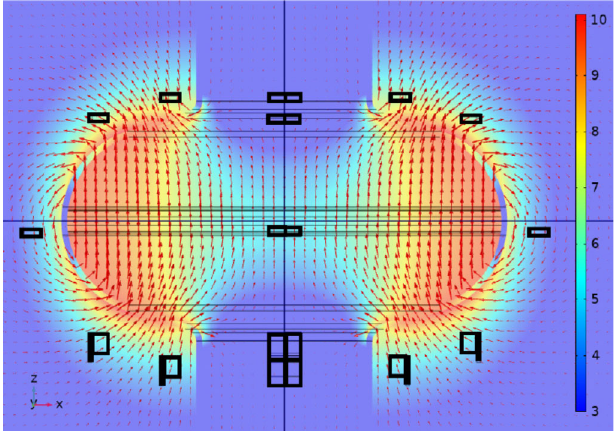
FIG. 5. Simulated slice through the cavity. A remanent B-field of up to 10 μ T with α ¼ 90 ° is set in the cavity walls. Here, only the B-field component perpendicular to the cavity ’ s surface is assumed to be trapped. Squares envelop the three sensors that belong to a group. Since the individual sensors in the lower two groups are spread further apart, squares are bigger (see Fig. 2).